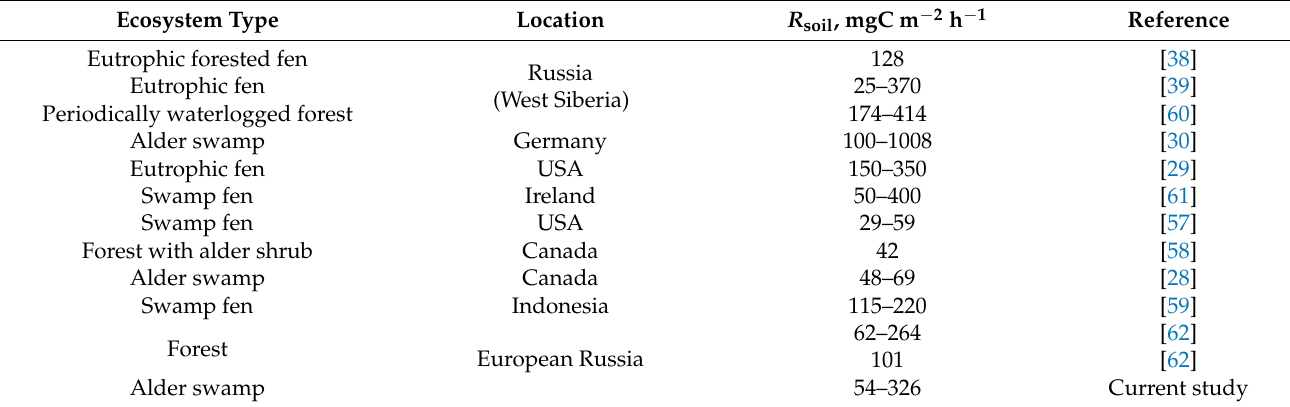
Table 3. Literature data on the level of soil respiration in black alder forests and ecologically close ecosystems. Ecosystem Type